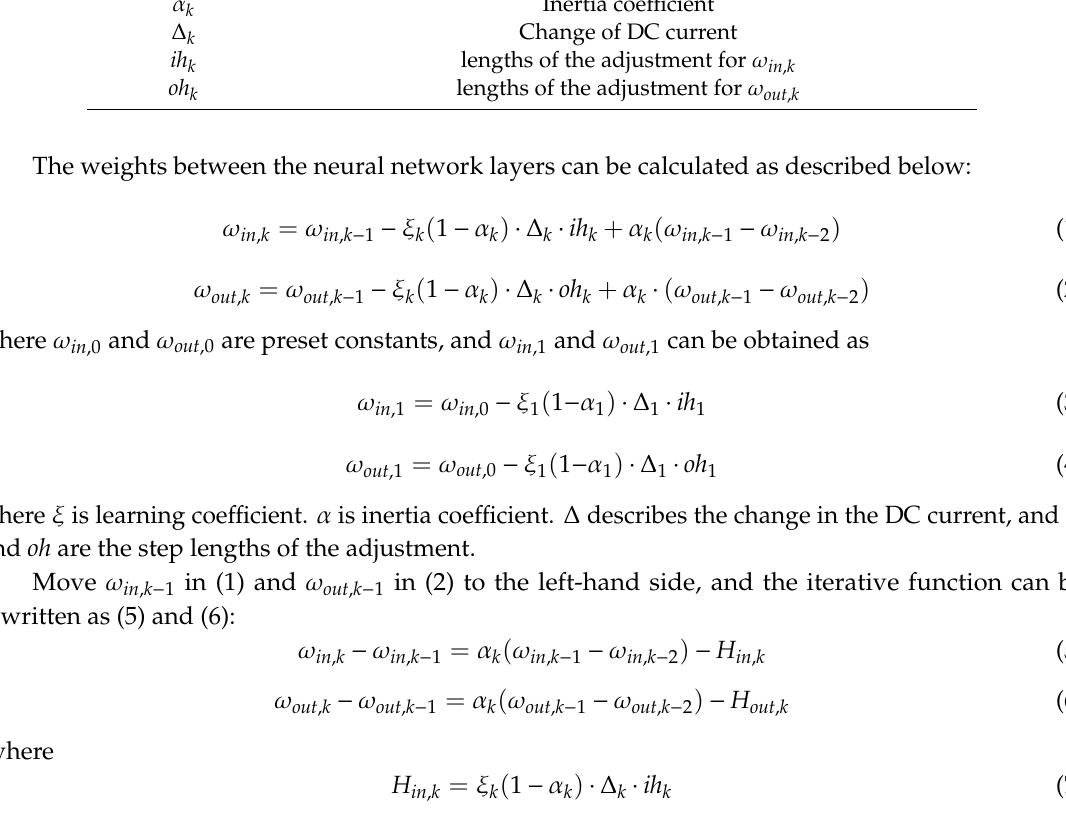
ffi cient ffi cient